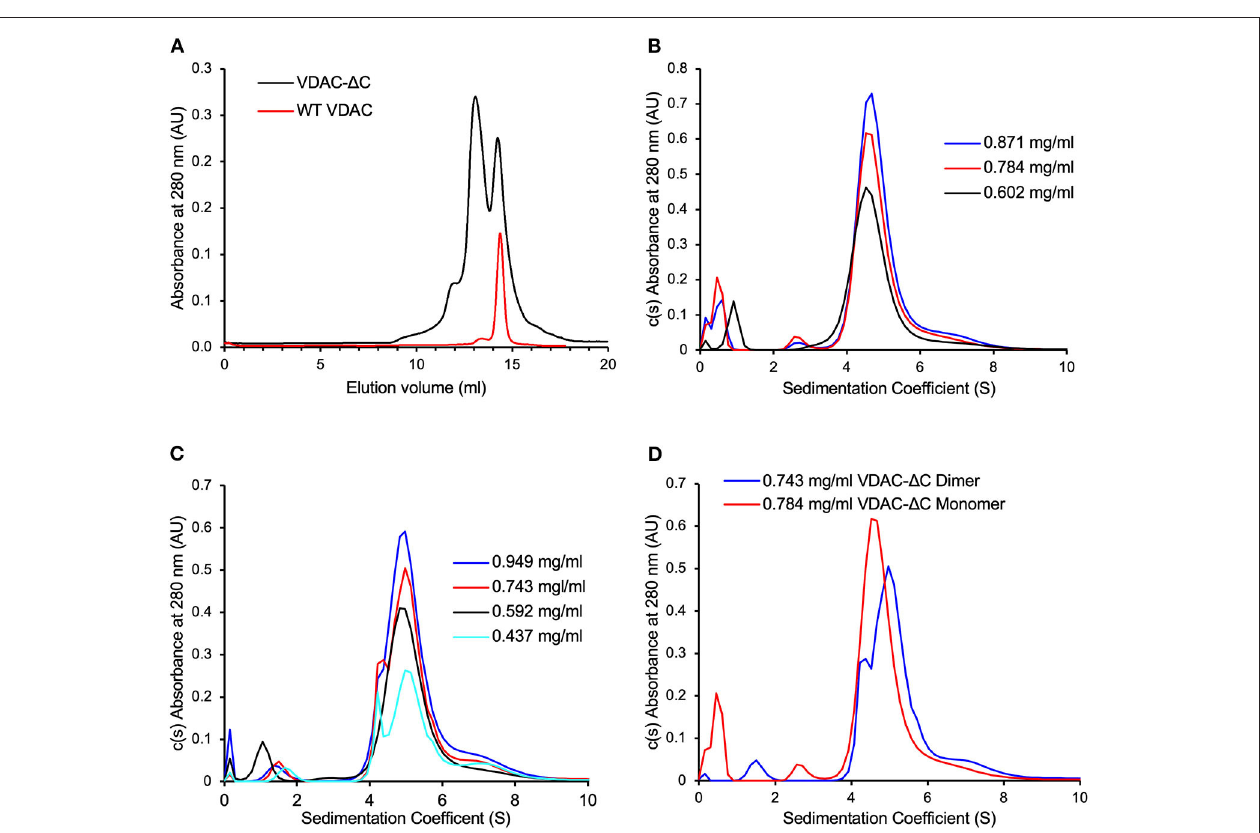
FIGURE 2 | VDAC- 1 C elutes as two major peaks, with the monomers and dimers not returning to equilibration after size exclusion chromatography (SEC) separation. (A) WT-VDAC, known to be monomeric, elutes as a single major peak with a similar elution volume to the VDAC- 1 C peak with larger elution volume (B) c(s) distribution of the VDAC- 1 C monomer SEC fractions at various VDAC concentrations. (C) c(s) distribution of the VDAC- 1 C dimer SEC fractions at various VDAC concentrations. (D) Comparison of the VDAC- 1 C monomer and dimer c(s) distributions at similar concentrations, showing differing populations in each sample. M w (tM w ) 31 kDa], which was in close agreement with previous major peaks, the lower elution volume peak corresponded to AUC experiments that analyzed the WT-VDAC in DM (Ferens the approximate M w of a dimer at 69 ± 1 kDa (tM w 60 kDa), while the higher elution volume peak corresponded to et al., 2019). VDAC- 1 C was eluted with a small shoulder peak, the approximate M w of a monomer at 37 ± 2 kDa (tM w 30 followed by two major protein-containing peaks. Of the two